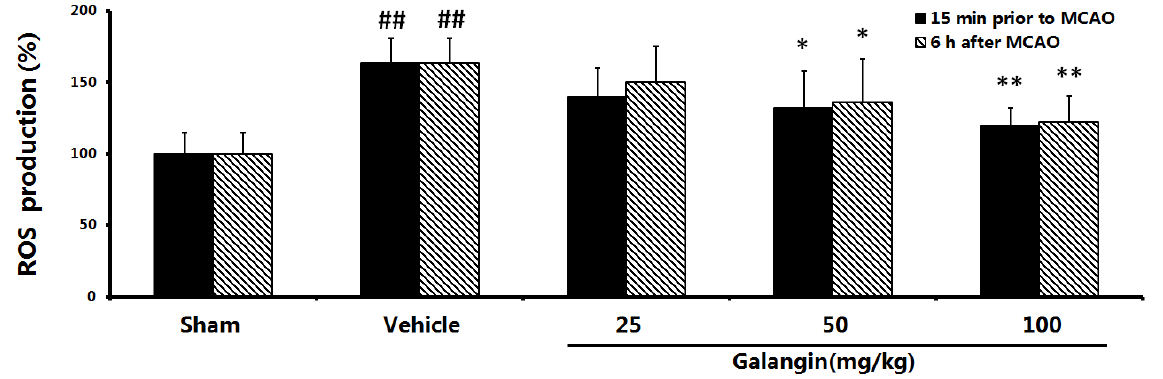
Figure 8. Effects of galangin on ROS generation in the brain mitochondria of MCAO rats. Galangin was administered by i.g. 15 min prior to MCAO and 6 h after MCAO. The mean mitochondrial ROS production in the sham group was set to 100%. The values were expressed as the mean ± SD (n = 10), and the data were analyzed by one-way ANOVA. ## p <